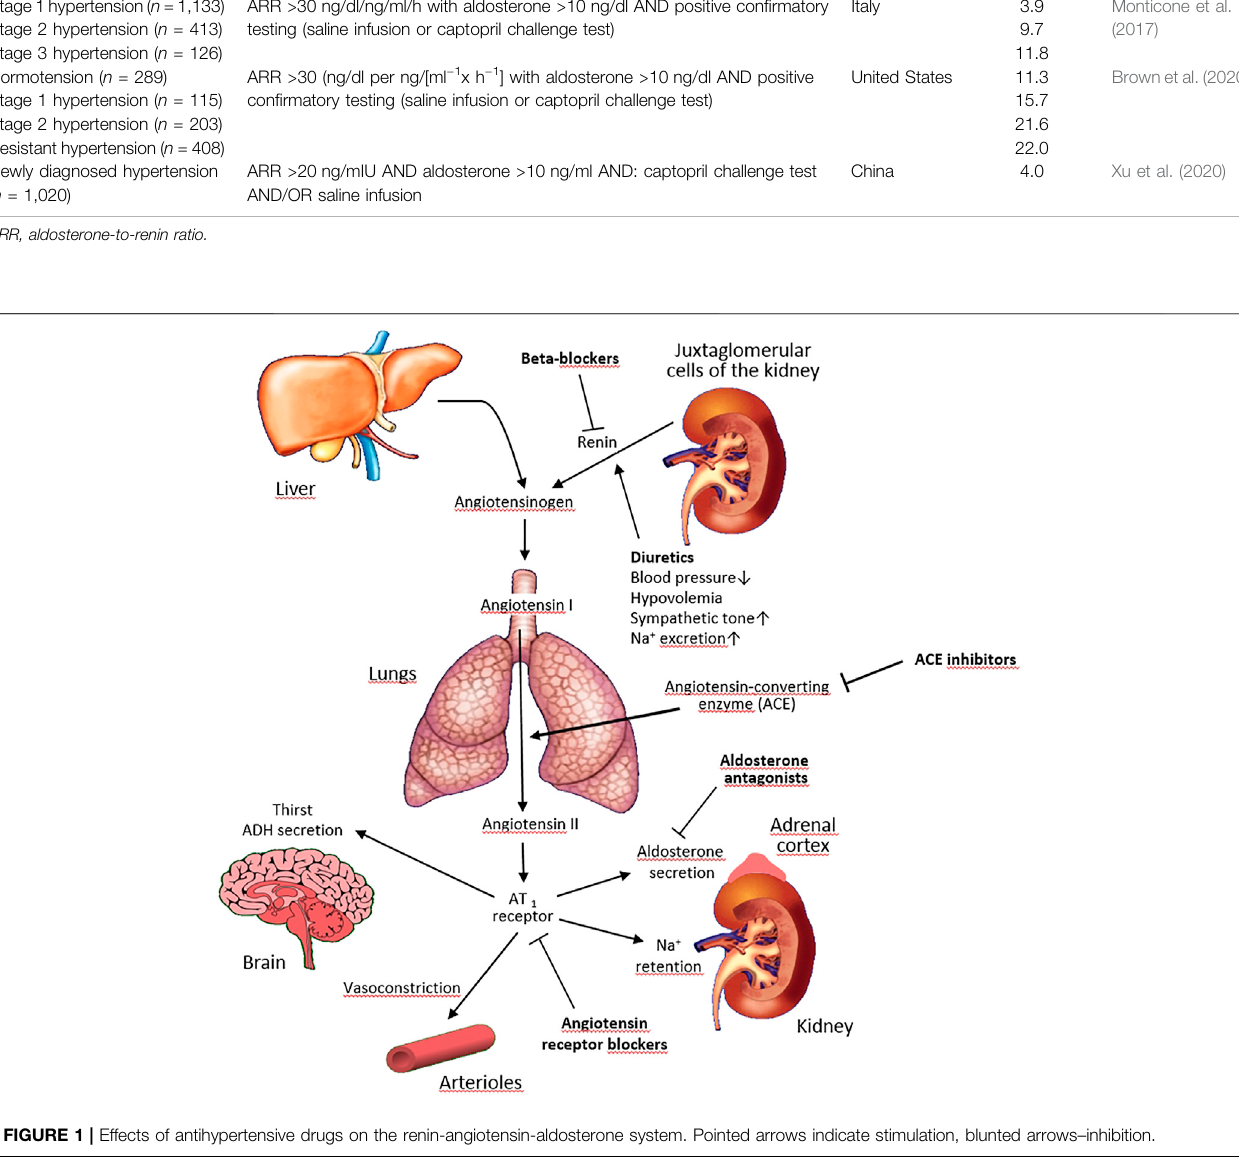
Frontiers in Pharmacology |